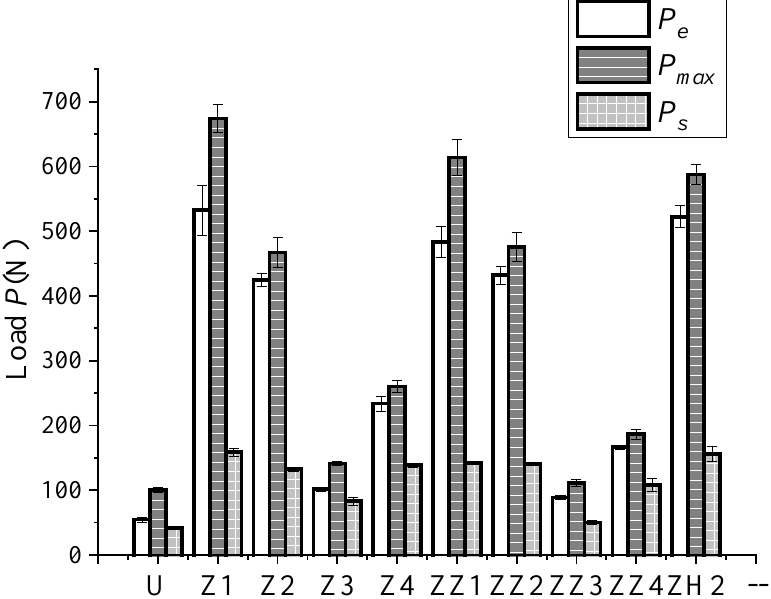
Figure 7. Pullout forces ( P e , P max , P s ).